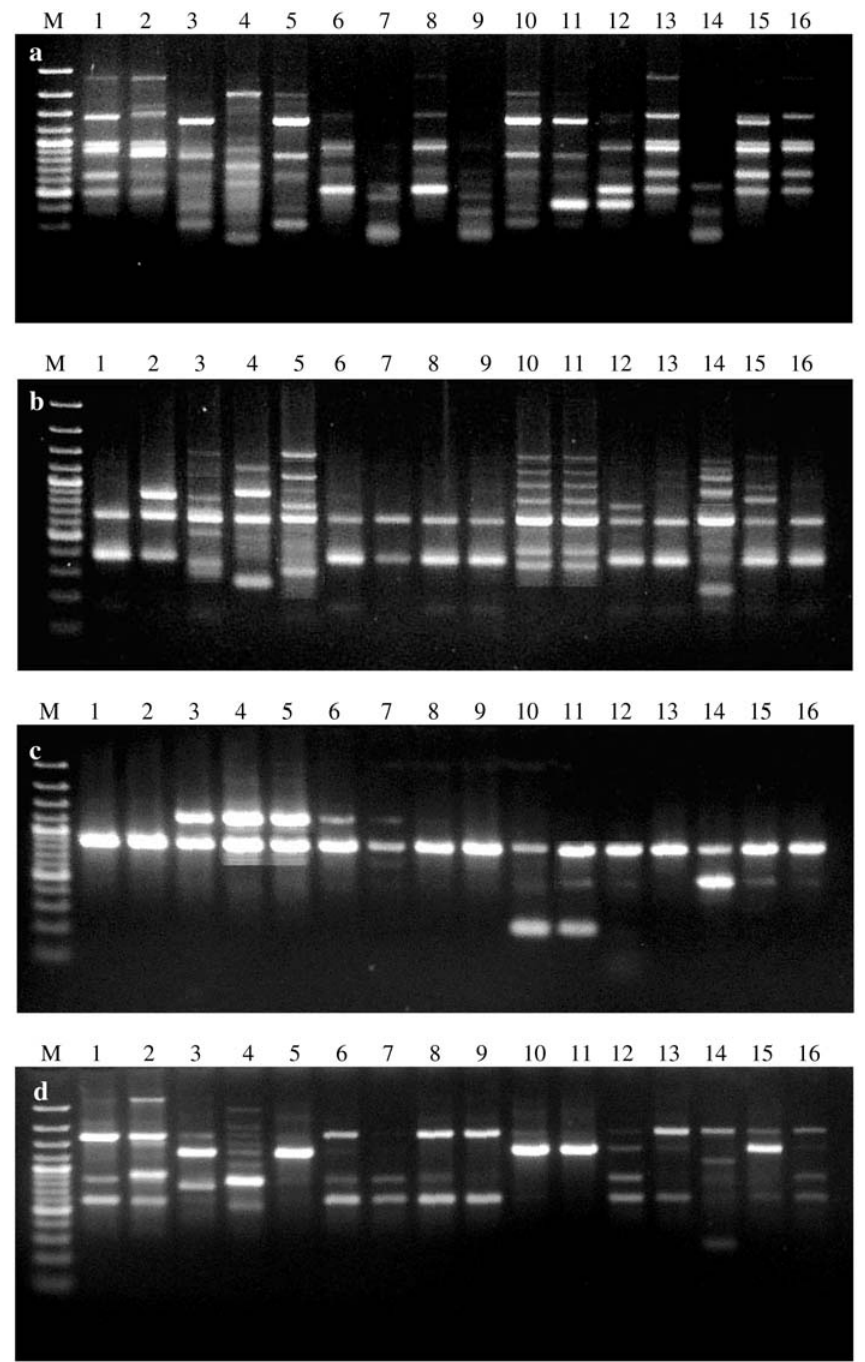
Fig. 1. RAPD pro fi le of Aspergillus niger aggregate isolates obtained with various primers: primer 01 (a), primer 02 (b), primer 06 (c) and OPA 18